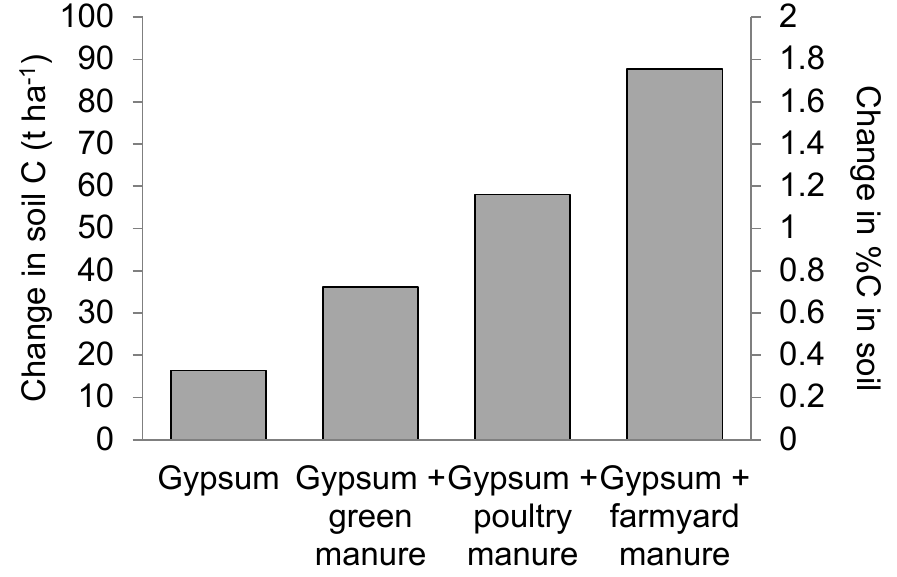
Figure 9. Simulated potential carbon (C) sequestration assuming continued application of the treatments used in the field study (left axis) change in C stock to a depth of 30 cm; (right axis) change in %C in the soil.